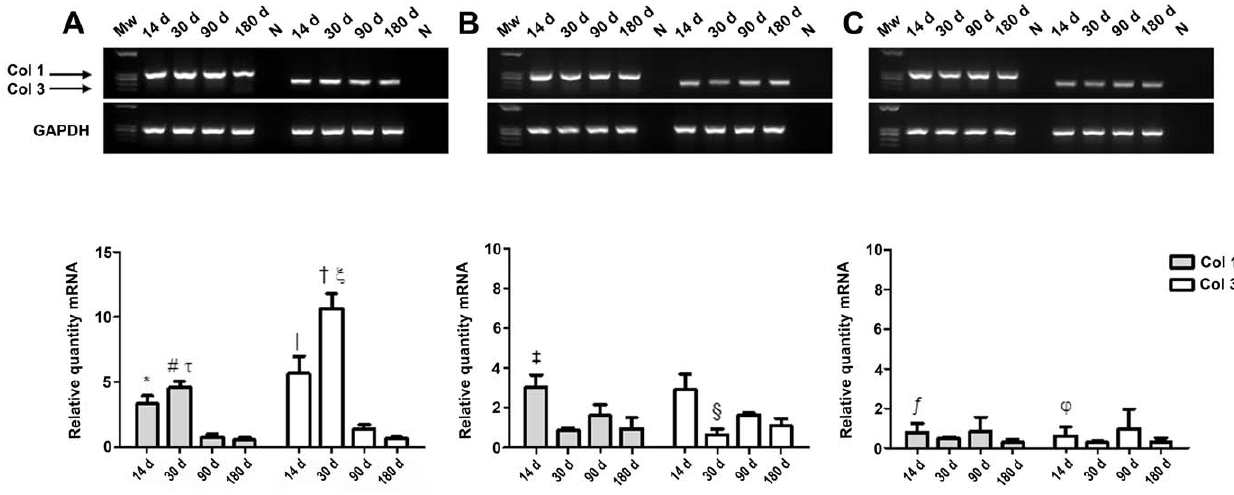
Figure 4. Collagen 1 and 3 mRNA expression determined by RT-PCR. Agarose gel product and relative mRNA quantity of Bio-A (A), Tuto (B) and St (C) after 14, 30, 90 and 180 days post-implantation. The results are expressed as the mean 6 SEM of three experiments. Gene expression was normalized with the GAPDH gene. A) Bio-A : Collagen (Col) 1: *, vs. 90 days ( P , 0.05) and 180 days ( P , 0.01); # , vs. 90 days ( P , 0.05) and 180 days ( P , 0.01); t , vs. Tuto ( P , 0.05) and St ( P , 0.01) at 30 days. Col 3: |, vs. 30 days and 90 days ( P , 0.05) and 180 days ( P , 0.001); { , vs. 90 days ( P , 0.05) and 180 days ( P , 0.001); j , vs. Tuto ( P , 0.05) and St ( P , 0.01) at 30 days. B) Tuto : Col 1: { , vs. 30 days ( P , 0.05). Col 3: 1 , vs. 14 and 90 days ( P , 0.05). C) St : Col 1: e , vs. Bio-A and Tuto at 14 days ( P , 0.01). (N=negative control; Mw=molecular weight